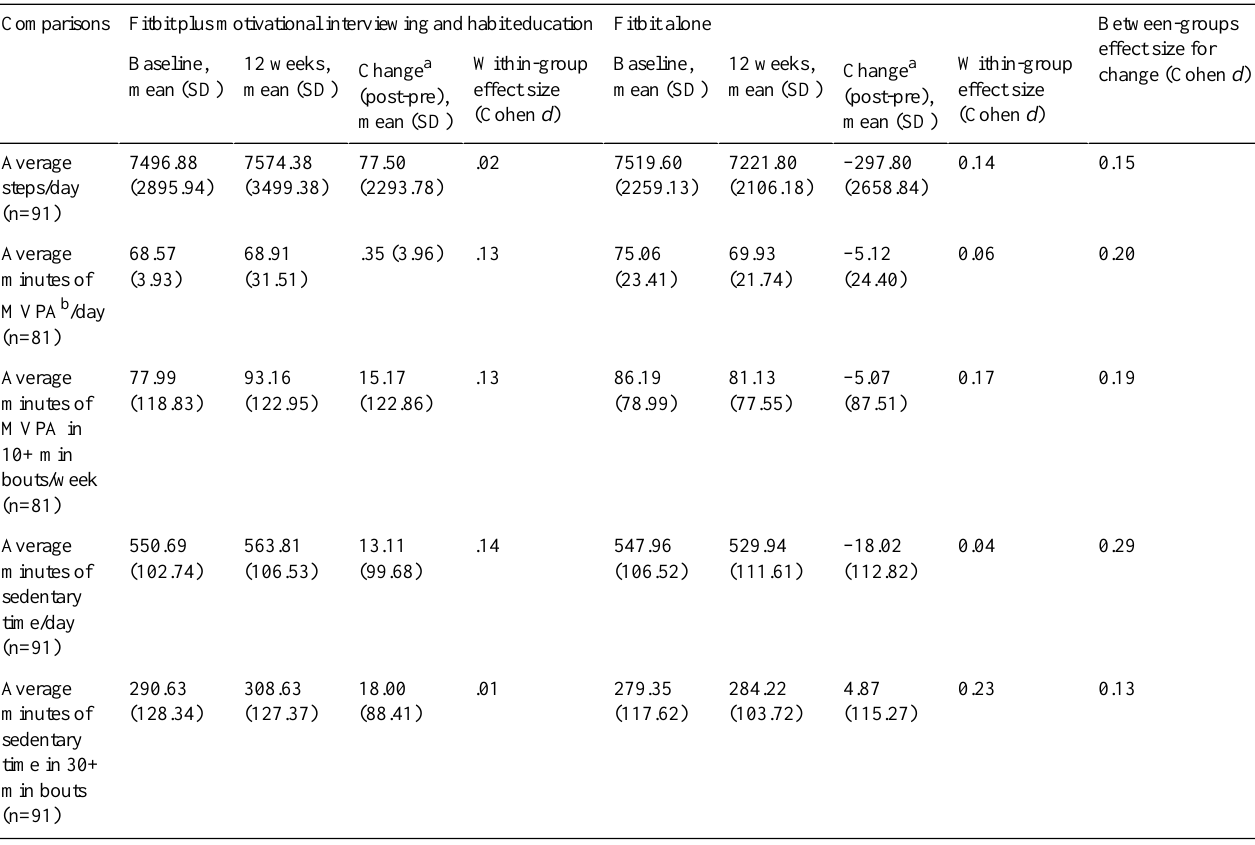
Table 2. Within- and between-groups comparisons of active and sedentary behaviors assessed using ActiGraph and activPAL monitors over the